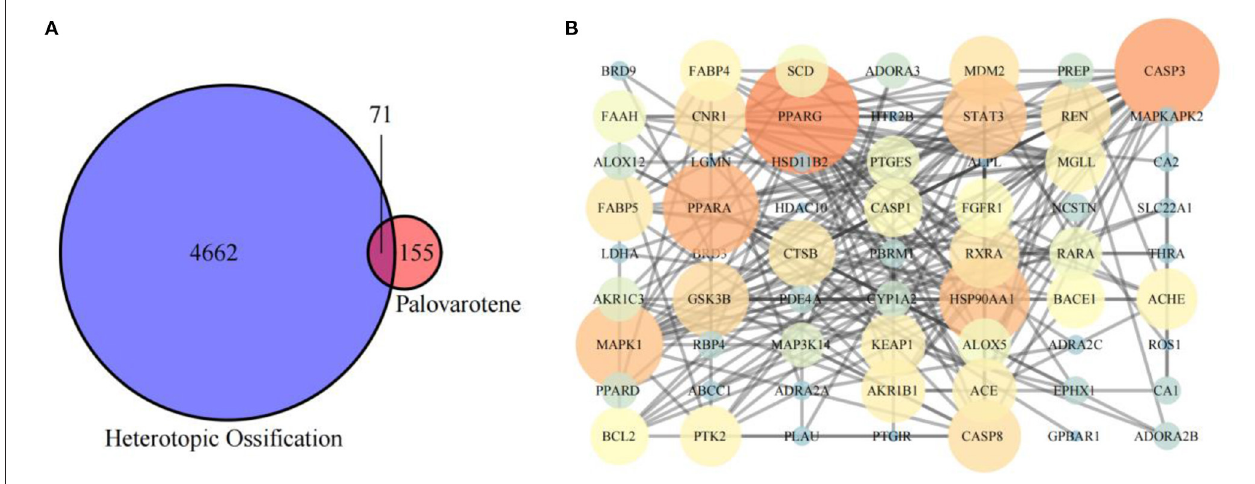
FIGURE 2 | (A) Intersection of Palovarotene-related genes and heterotopic ossification related genes; (B) PPI network of potential targets of Palovarotene to treat heterotopic ossification.